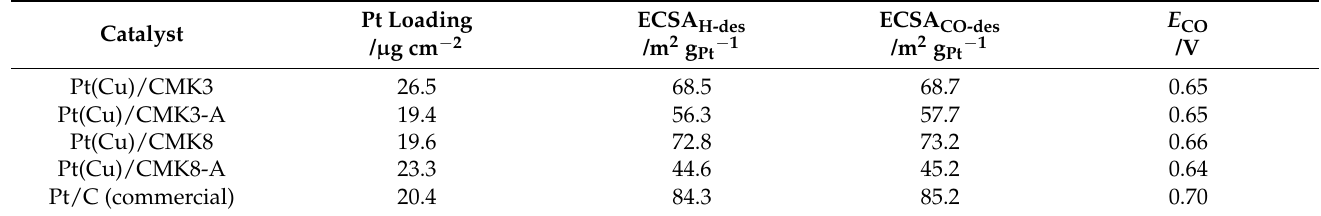
Table 3. Pt loadings for electrochemical testing, ECSAs measured from hydrogen desorption (H-des) and CO stripping (CO-des) and onset potentials for CO oxidation ( E CO ) in the corresponding cyclic voltammograms.